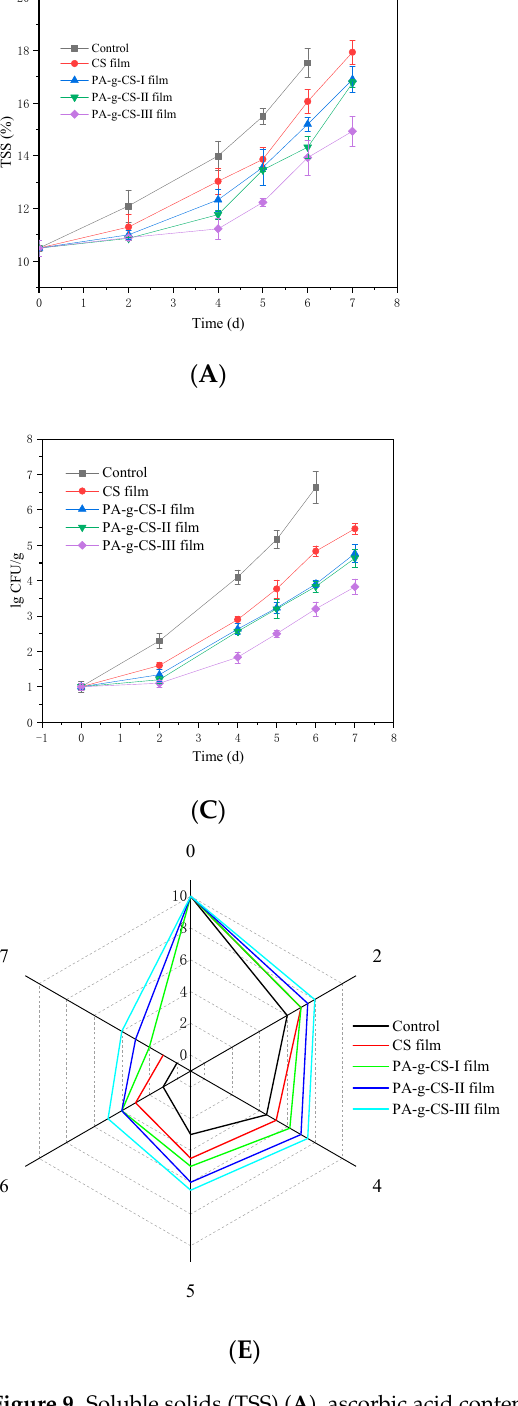
Figure 9. Soluble solids (TSS) ( A ), ascorbic acid content ( B ), total bacterial count ( C ), relative conductivity ( D ), and sensory evaluation ( E ) of fresh-cut jackfruit.